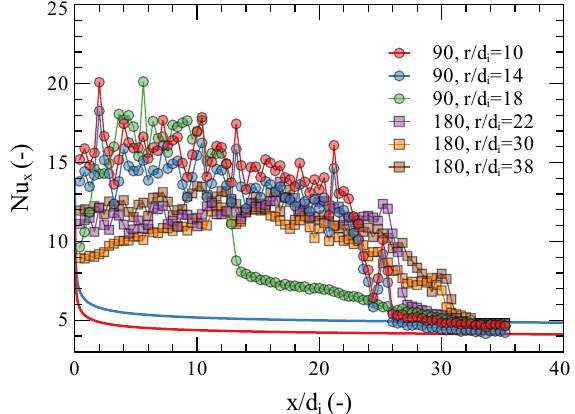
Figure 16. Comparison of experimentally measured data for both geometries of bent pipes with a theoretical straight horizontal pipe. Data are plotted for one Reynolds number for 90 bend geometry (Re = 1059) and one for 180 bend geometry (Re = 847). The length resolution does not correspond to reality; the datasets were stretched so that they end at the same distance. The red and blue solid lines represent the equations for the two basic boundary